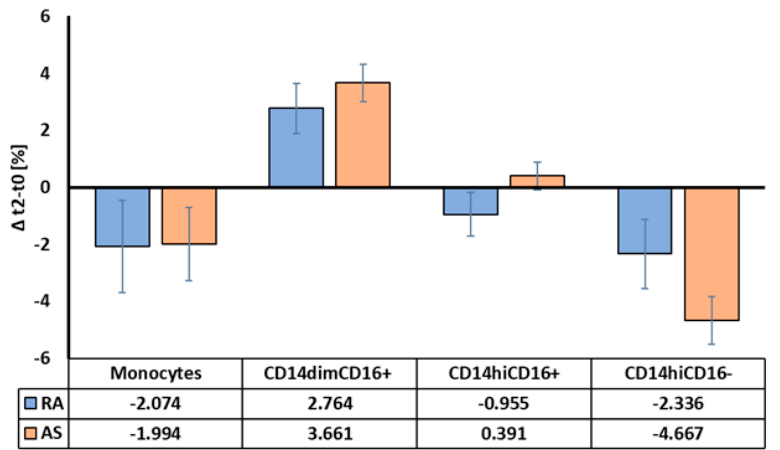
Figure 3. Monocytes and their subpopulations in RA and AS groups treated with TNFi. Data was calculated as a delta t2 − t0. Error bars represent SEM.